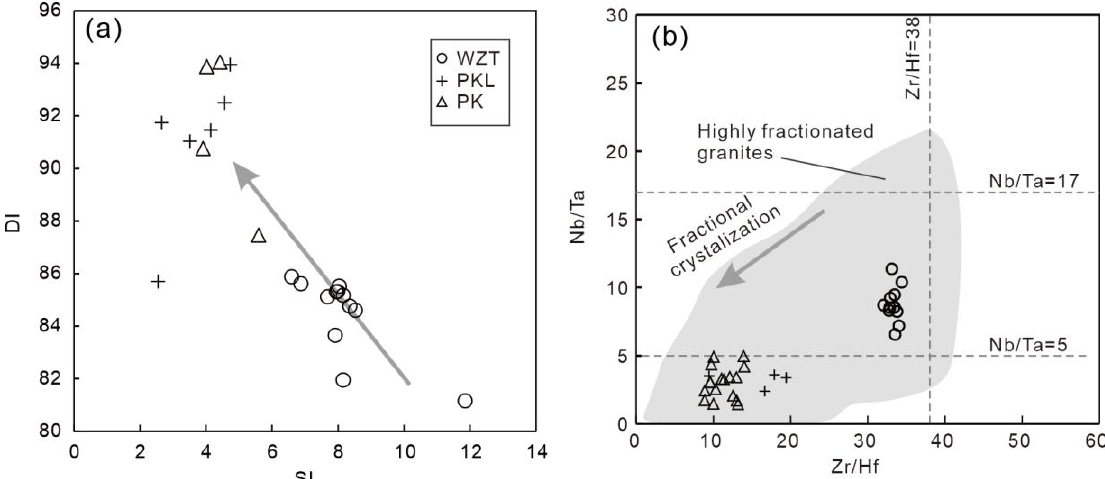
Figure 11. Binary diagrams showing the degree of differentiation of the Wuzhutang granite from the Xuebaoding mining area, Sichuan Province, China. ( a ) Plot of SI vs. DI of the Wuzhutang granite. ( b ) Plot of Zr/Hf vs. Nb/Ta of the Wuzhutang granite. Data of highly fractionated granites are from [44], data of the Pankou and Pukouling granites are from [38,39].